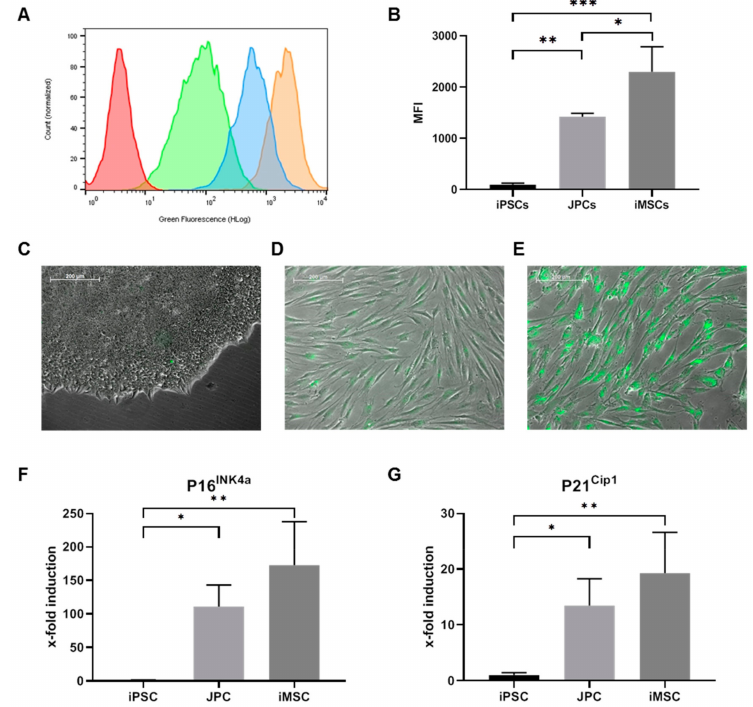
Figure 6. Cellular senescence of JPCs, iPSCs, and iMSCs. Determination of SA- β -galactosidase activity using a fluorescent SA- β -gal assay kit. ( A ) Representative histogram of SA- β -gal activity detected in iPSCs (green), JPCs (blue), iMSCs (orange) and an unstained control (red) by flow cytometry and ( B ) median fluorescence index (MFI) values displayed as mean values ± SD, compared by one-way ANOVA. Fluorescent SA- β -gal activity detected by fluorescence microscopy in ( C ) iPSCs, ( D ) JPCs and ( E ) iMSCs (10 × magnification, scale bar = 200 µ m). Expression of senescence marker genes ( F ) P16 INK4a and ( G ) P21 Cip1 is displayed as induction values relative to the expression of iPSCs (control) and compared by one-way ANOVA ( n = 3, * p < 0.05, ** p < 0.01, *** p <